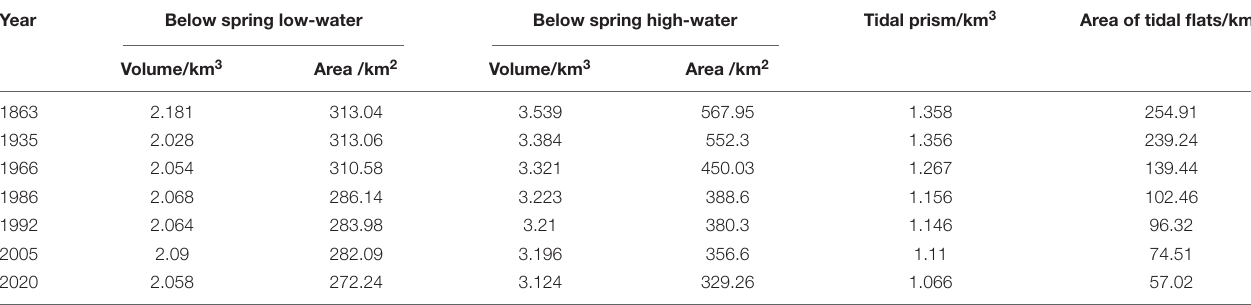
TABLE 2 | Tidal prism and area of tidal flats of Jiaozhou